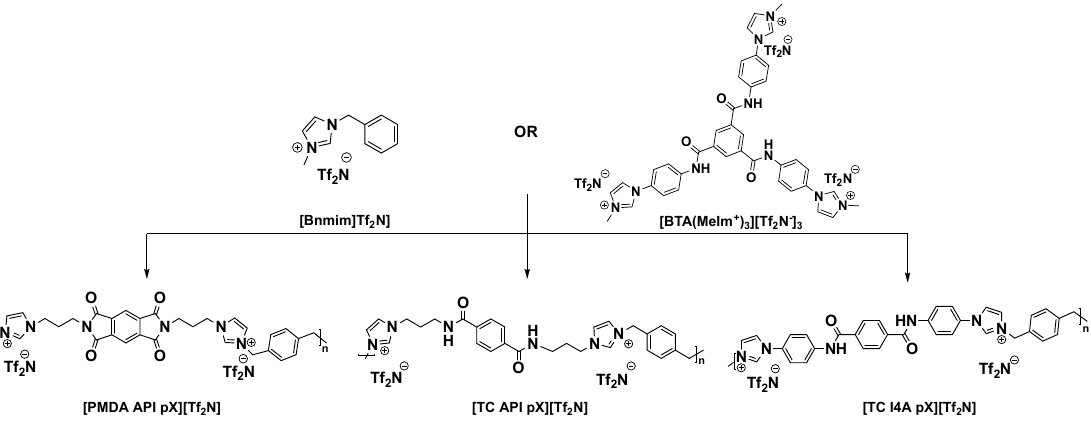
Scheme 3. Structures of additives, [Bnmim][Tf 2 N] and [BTA(MeIm + ) 3 ][Tf 2 N - ] 3 , incorporated into neat